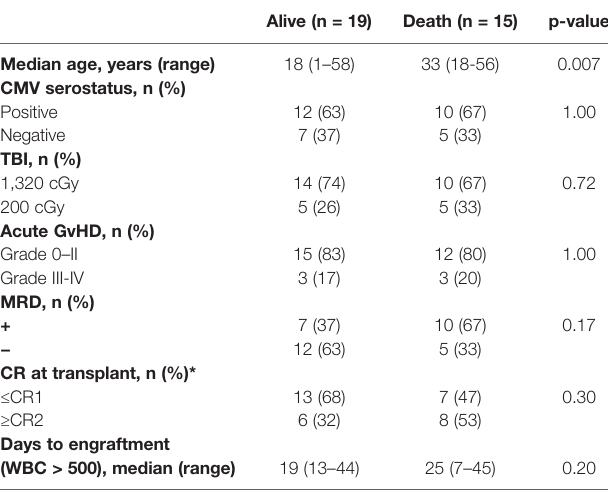
TABLE 2 | Outcomes